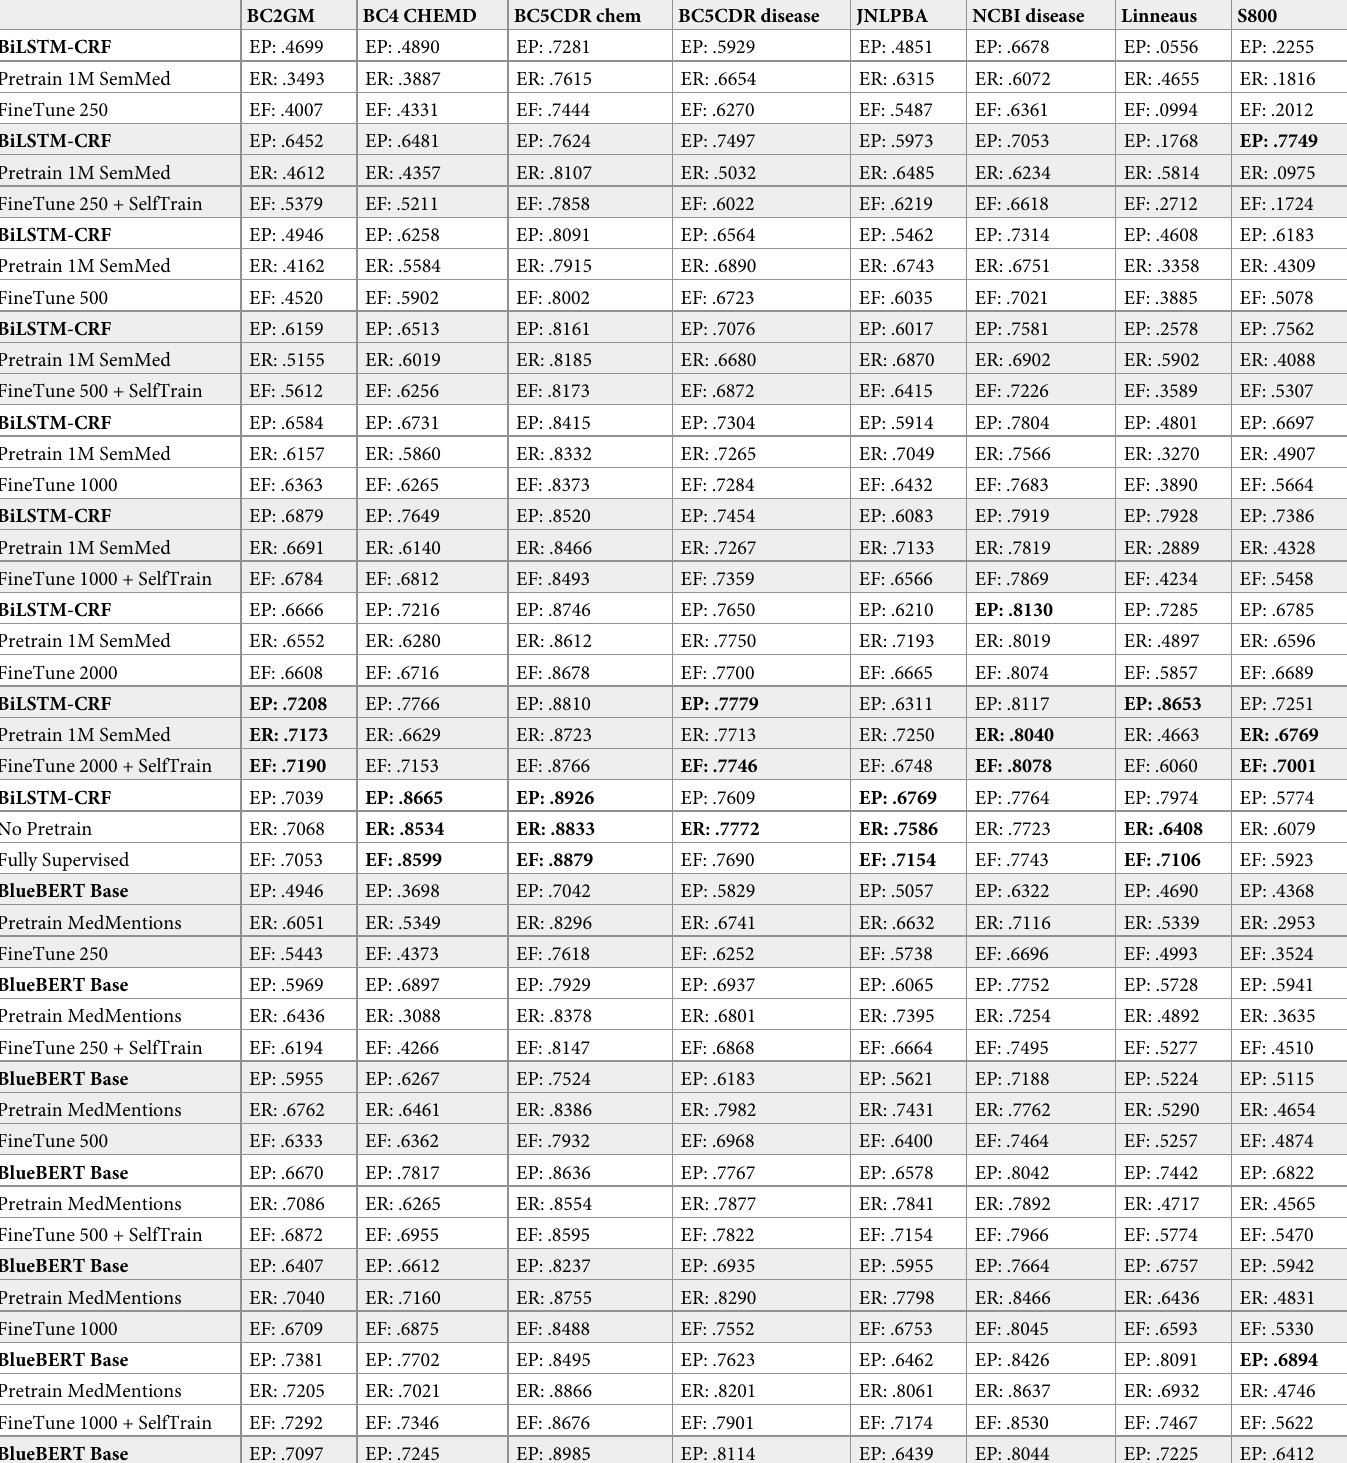
Table 6. Exact precision, recall, and F1 score of the BiLSTM-CRF and BlueBERT on each of our target datasets when fine-tuning on different amounts of labeled sentences, with and without semi-supervised self-training. A fully supervised version is included for comparison. For all sets of training data, 80% of the available data is used for training and 20% of the available data is used for